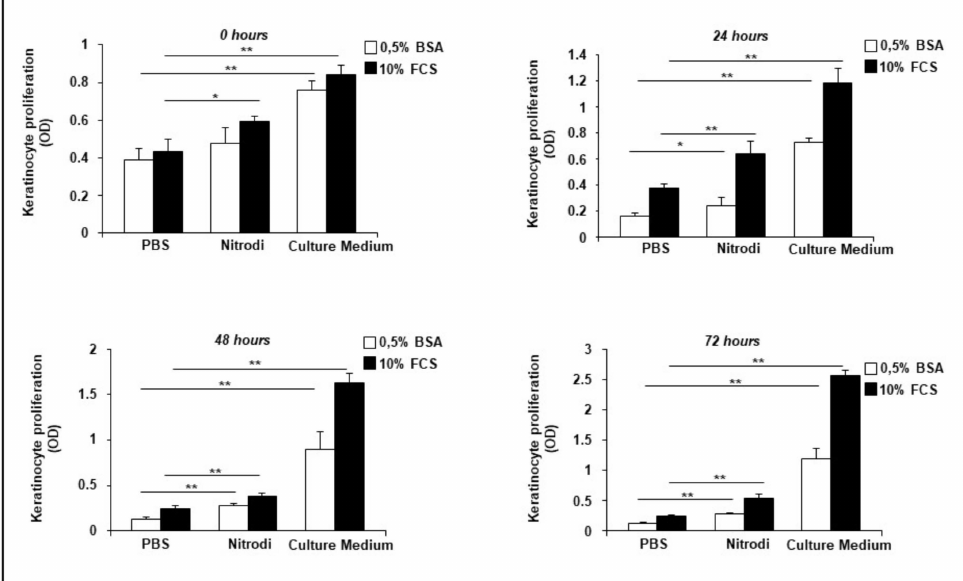
Figure 5. Effects of Nitrodi’s water on HaCaT cell proliferation. Cells were grown in 96-well plates for 0, 24, 48, and 72 h, in the presence 0.5% BSA (white column) and 10% FCS (black column). Cell viability was tested by CellTiter 96 Aqueous One Solution Reagent. Cells treated with Nitrodi supplemented with 0.5% BSA and cells treated with culture medium supplemented with 0.5% BSA were compared to cells treated with PBS supplemented with 0.5% BSA at each time point. Cells treated with Nitrodi supplemented with 10% FCS and cells treated with culture medium supplemented with 10% FCS were compared to cells treated with PBS supplemented with 10% FCS at each time point. Error bars represent standard deviation of the mean of triplicate samples within one